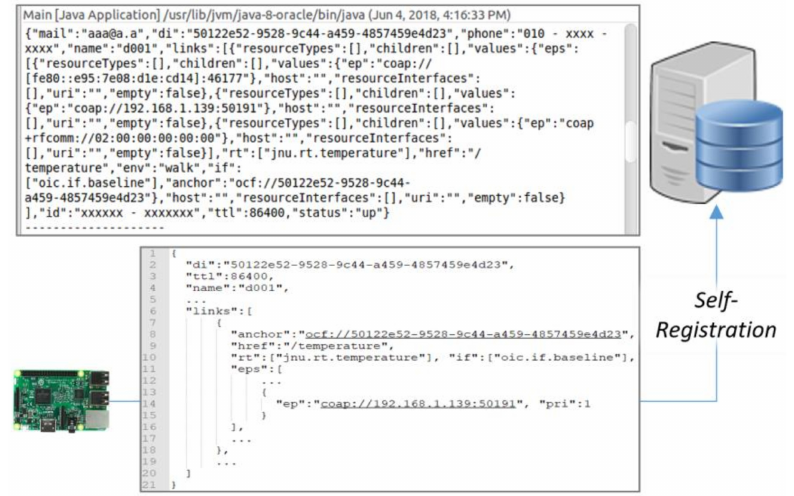
Figure 11. Interaction result for